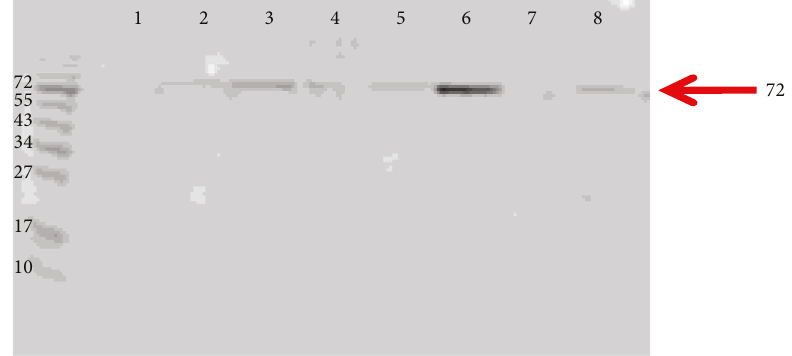
Figure 5: Detection of a 72kd Hb immunoreactive band on native HDL. Eight HDL samples from diabetic individuals were loaded on an SDS-PAGE gel and transferred to a PVDF membrane. Anti-Hb antibody was added to the membrane, as described in Methods. A 72 kd band was seen (arrow) indicating the presence of a cross-linked species.